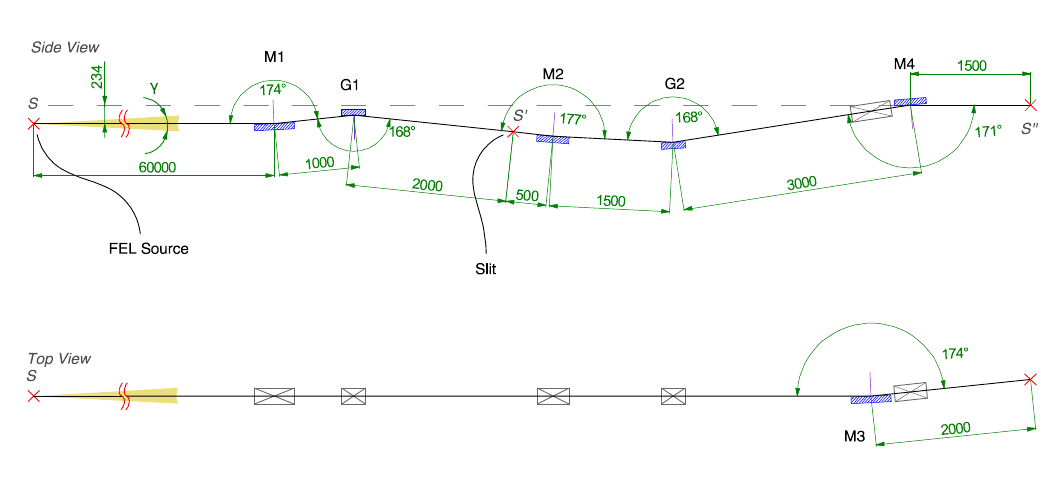
Figure 4. Optical layout of a double-grating monochromator for FEL